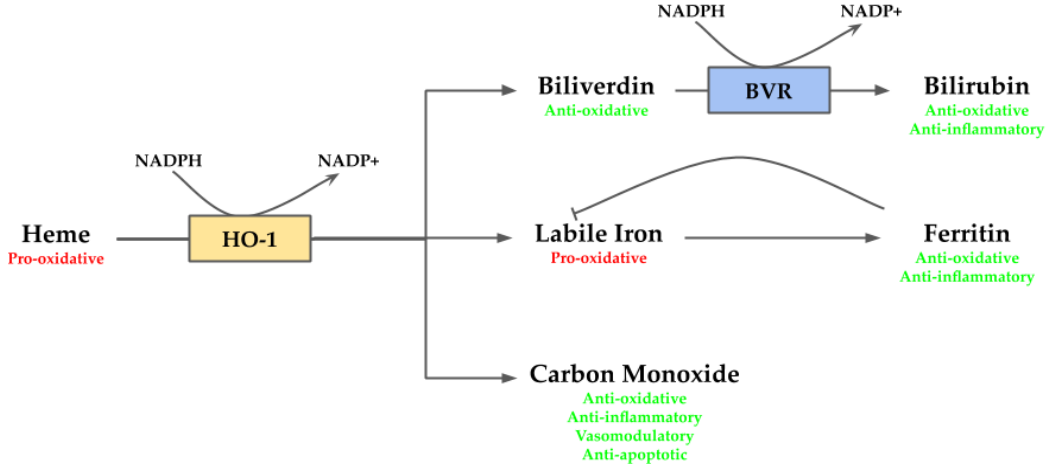
Figure 2. Overview of heme oxygenase (HO-1) system. Heme, a pro-oxidant molecule, is degraded by HO-1 into biliverdin, labile iron and carbon monoxide (CO). Labile iron can act as pro-oxidant through Fenton reaction, but it stimulates ferritin transcription, which stores it exerting anti-oxidative and anti-inflammatory activities. CO takes part in several downstream processes and eventually may act as anti-oxidative, anti-inflammatory, vasomodulatory and anti-apoptotic agent. Biliverdin is an anti-oxidative molecule, which is rapidly converted by biliverdin reductase (BVR) into bilirubin providing anti-oxidative and anti-inflammatory functions.